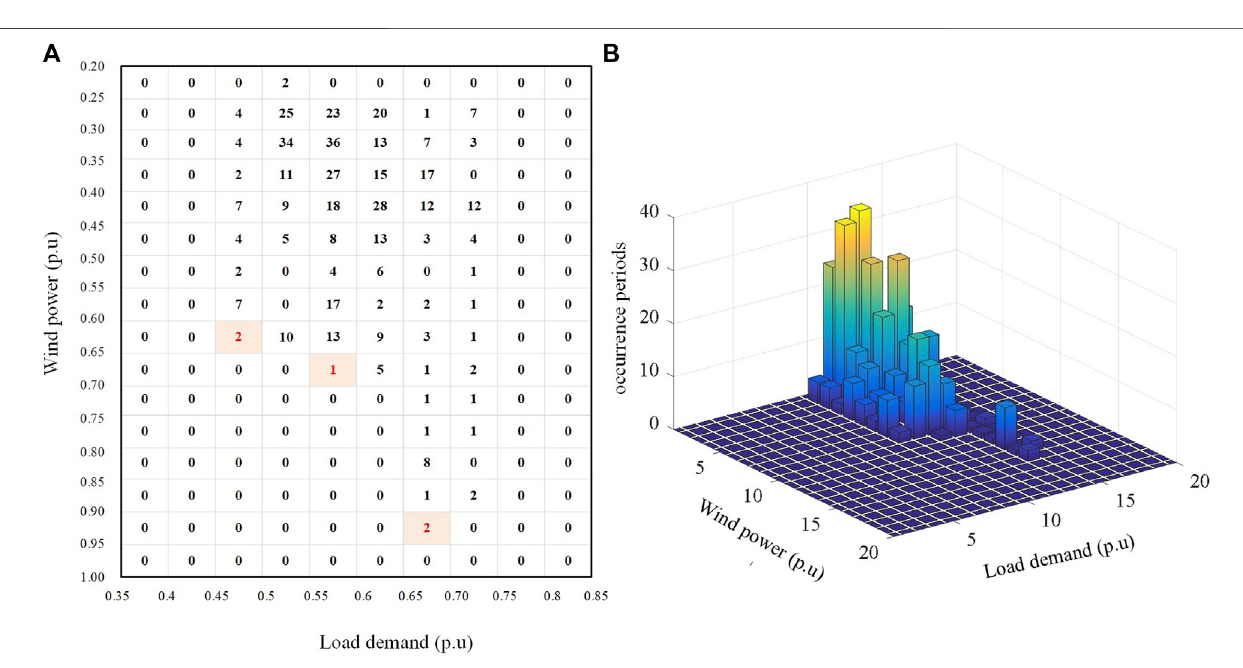
FIGURE 3 | (A) Occurrence periods for all combinations when the bin width is 0.05 p.u; (B) Visualization of all wind – load aggregated